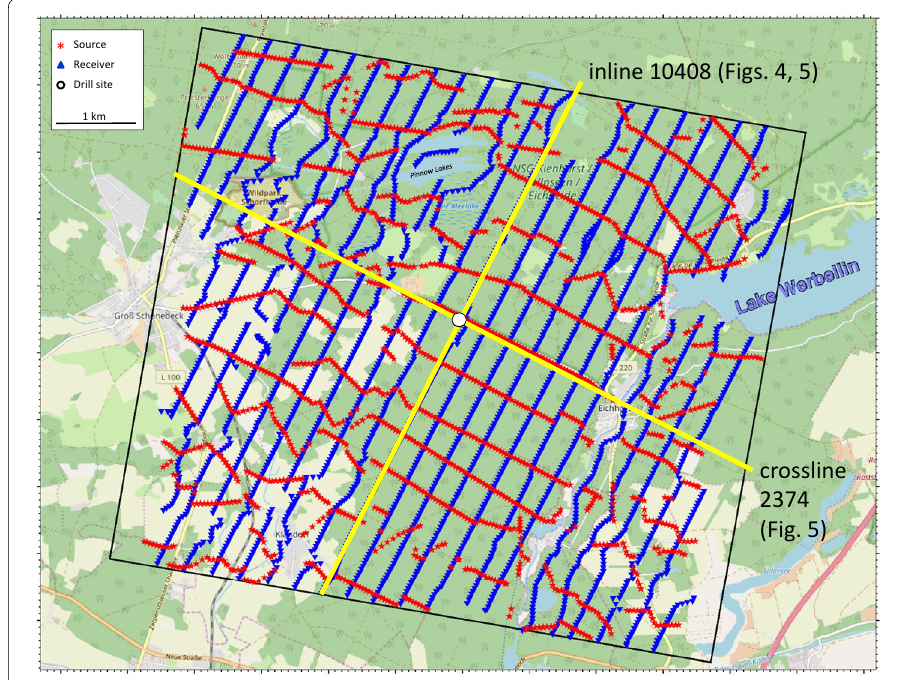
Fig. 3 Actual pattern of the 3-D seismic survey (for location see Fig. 1) with sources (red stars, crosslines) and receivers (blue triangles, inlines) lines. The drilling site (marked with white filled circle at surface location) is traversed by the two sections (yellow lines) shown in Figs. 4 and